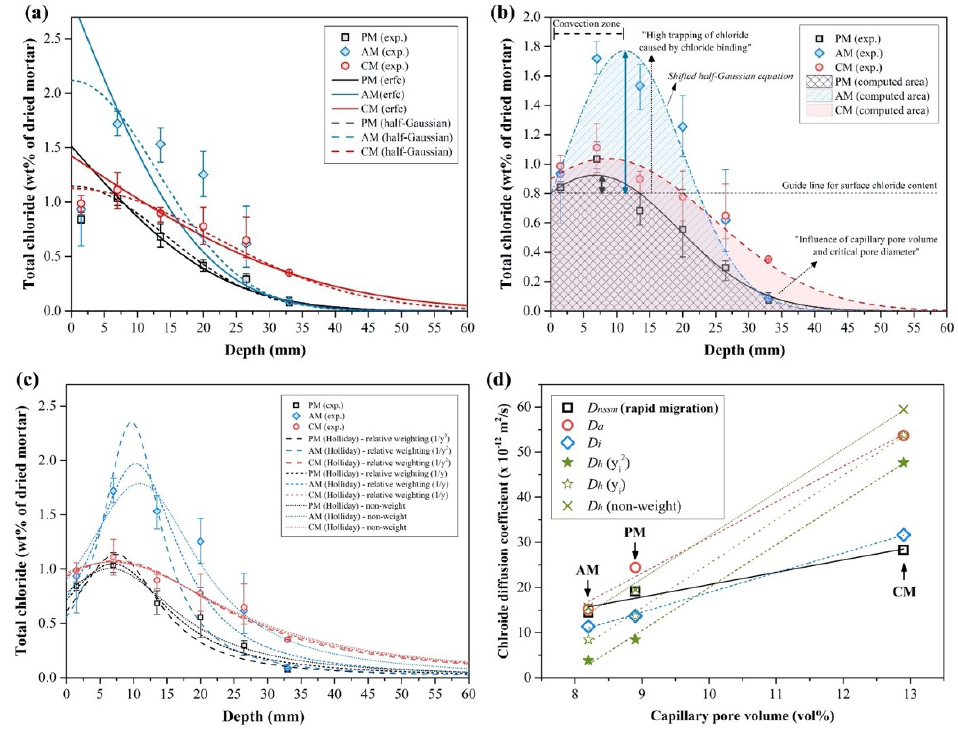
Figure 9. Results of the natural chloride diffusion test and the curve fitting by ( a ) inverse error function and half-Gaussian equation, ( b ) shifted half-Gaussian equation and ( c ) Holliday equation. ( d ) Comparison of the calculated chloride diffusion coefficients between the rapid migration test and the natural diffusion test.